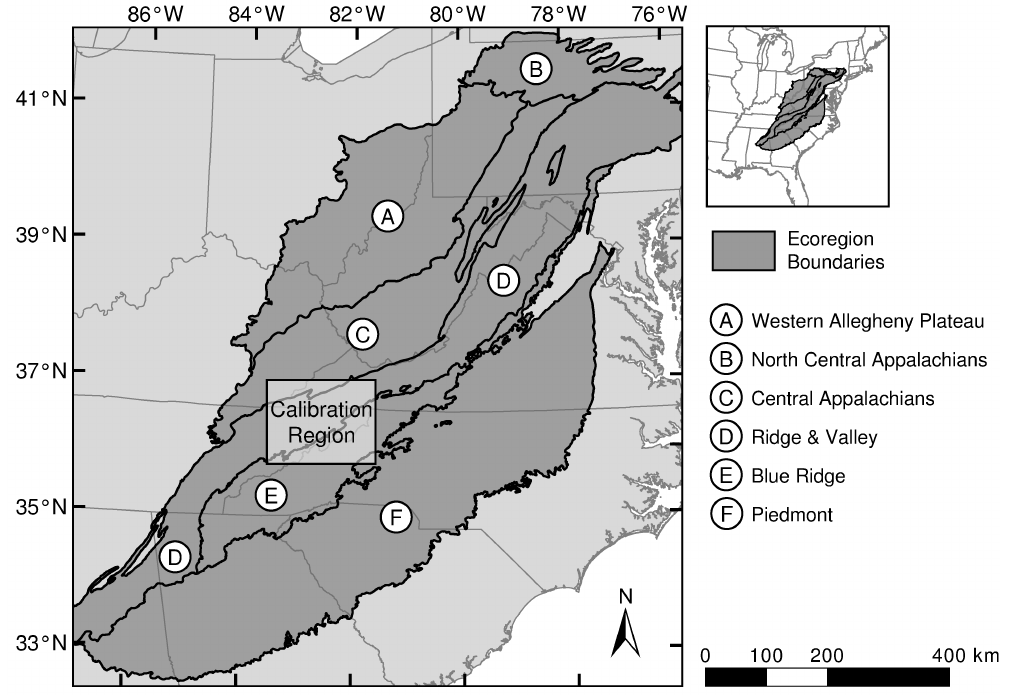
Figure 1. Study area showing ecoregions of interest in the Eastern United States and the subset calibration region within which model parameters were